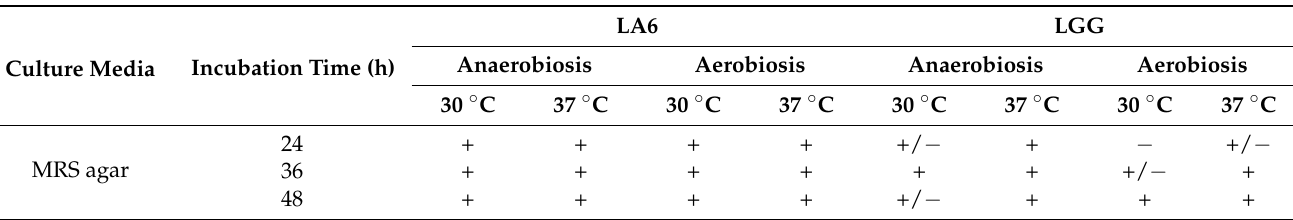
Table 6. Growth of LA6 and LGG in media agar at 30 ◦ C and 37 ◦ C under aerobiosis and anaerobiosis conditions.